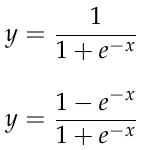
where x is the independent variable, and j is the dependent variable. The input value of Logsig function and Tansig function can take any value, and the range of the output value is (0,1) and ( − 1,1), respectively. The image of the logsig function and tansig function is as shown in Figures 6 and 7, respectively.